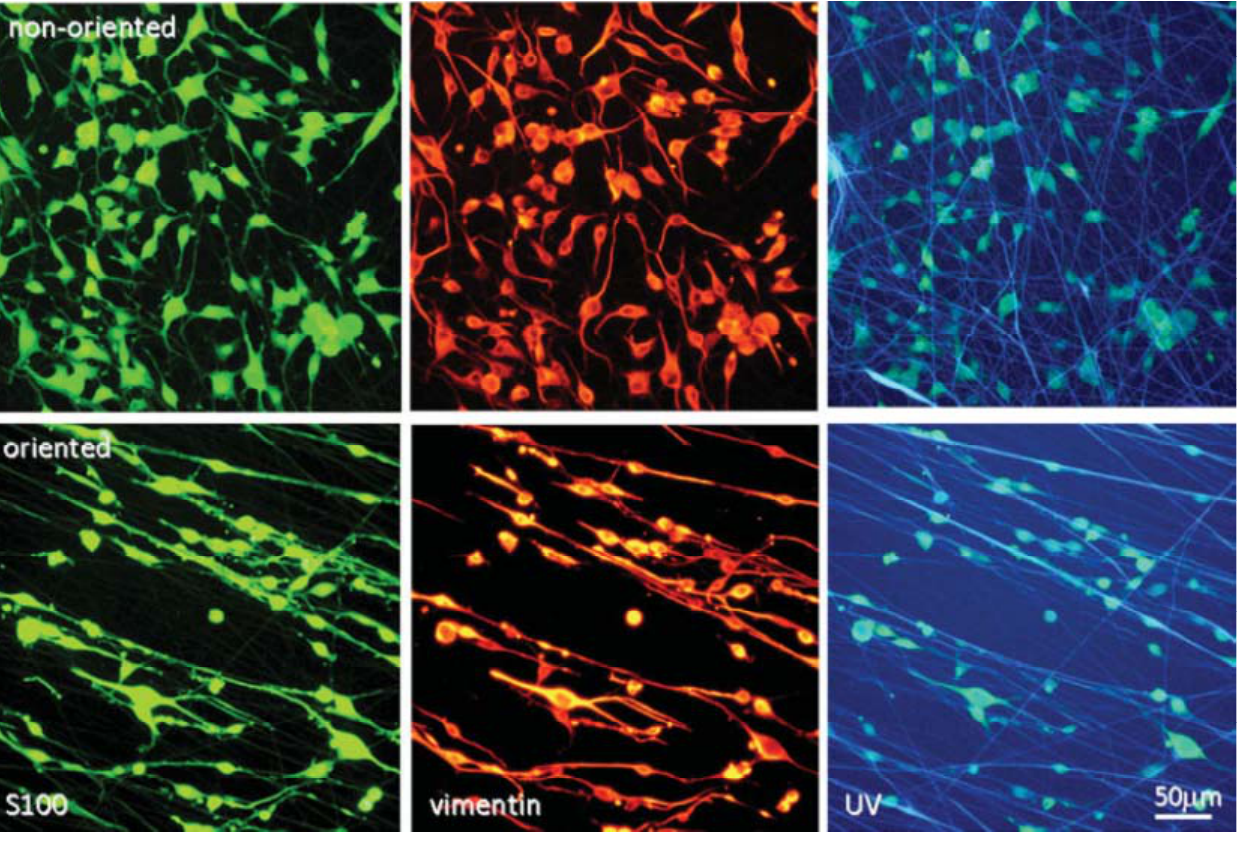
Figure 9. Schwann cell line cultured for 4 days on both random and oriented electrospun chitosan nanofiber coverslips. The row shows Schwann cells cultured on random fibers, while the bottom row shows Schwann cells cultured on oriented fibers. Reprinted from [290] with permission from John Wiley and